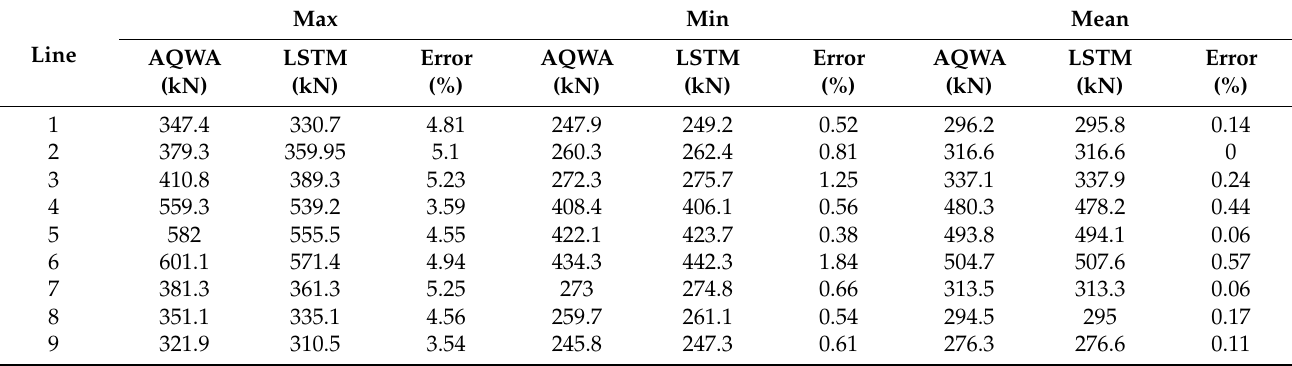
Table 10. Result statistics of mooring tensions in Case 1.